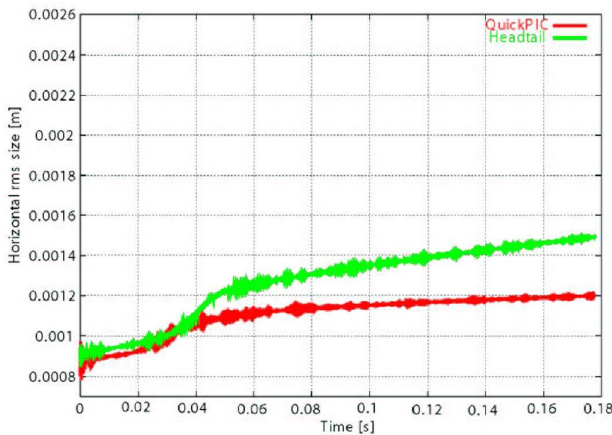
FIG. 47. (Color) Horizontal emittance growth for LHC example parameters as a function of time simulated by HEADTAIL (green curve) and by the discretized QUICKPIC (red curve) with a single electron-beam interaction per